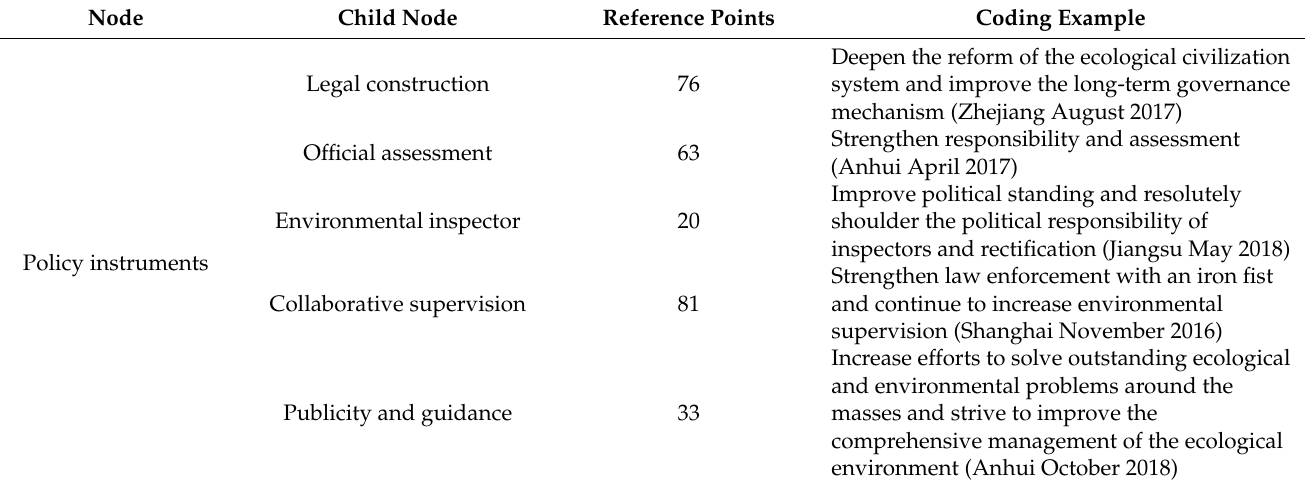
Table 7. “Policy instruments”, node hierarchy and coding information table. Node Child